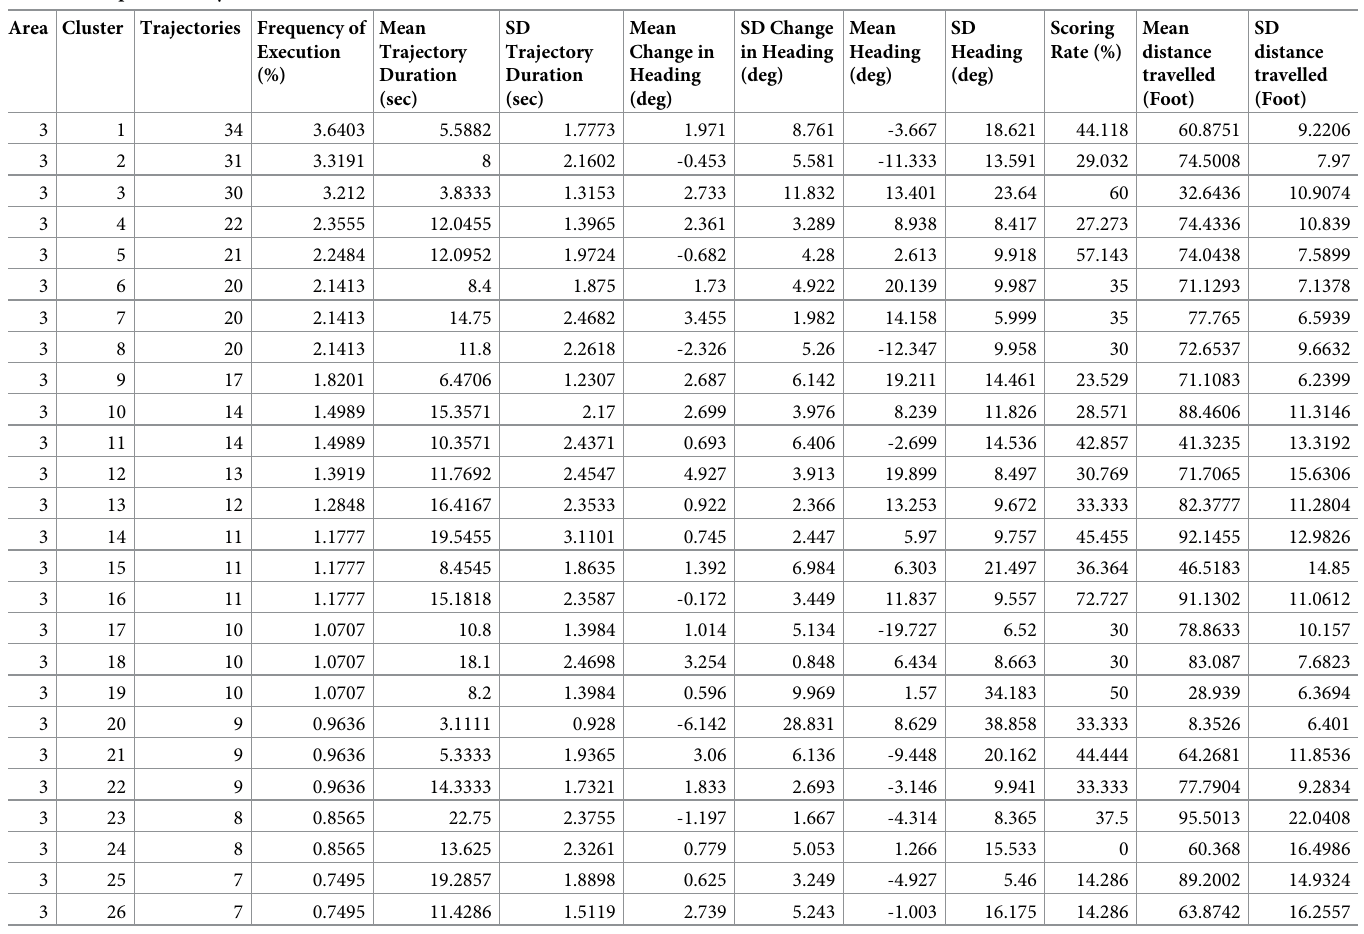
Table 1. Sample summary statistics for Area 3 Australia data.